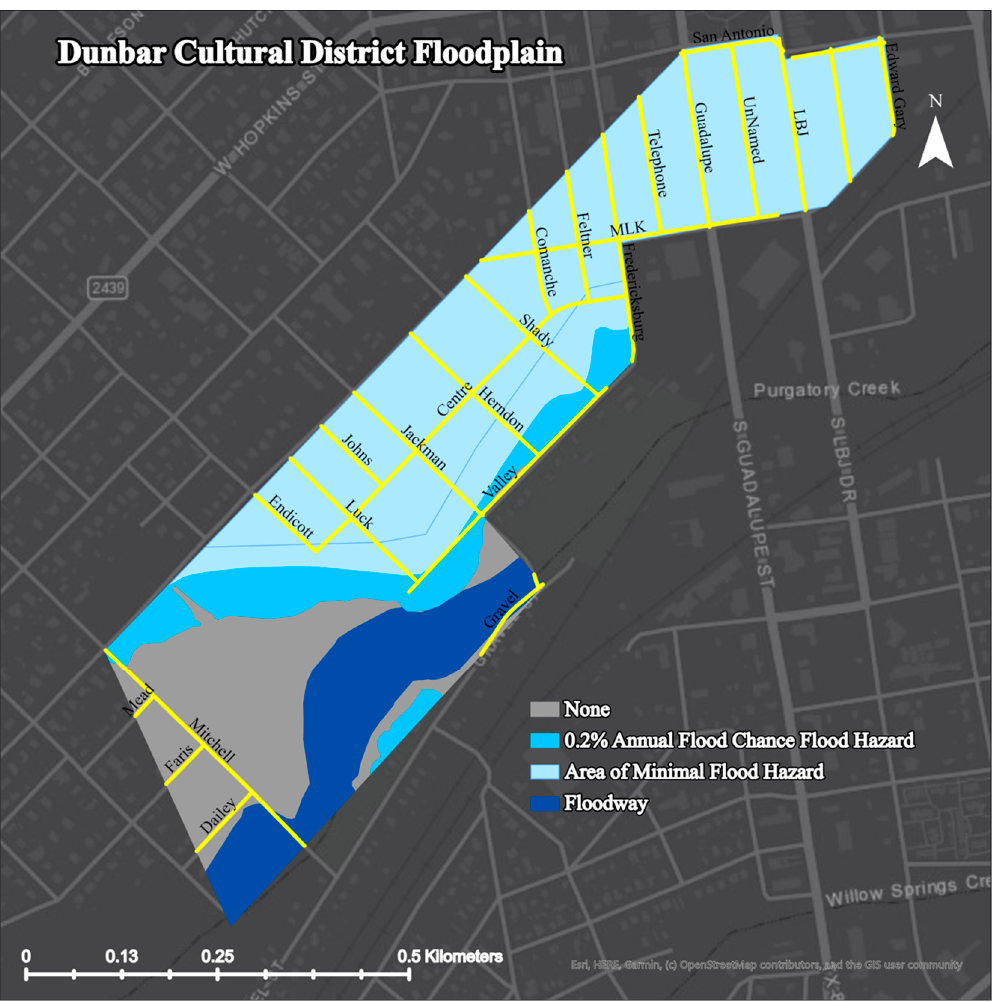
Figure A4 . Dunbar Cultural District Floodplain (includes roads). Dunbar Cultural District floodplain map with roads information. Data for this map were obtained from the Federal Emergency Management Agency, City of San Marcos, and Esri basemaps.